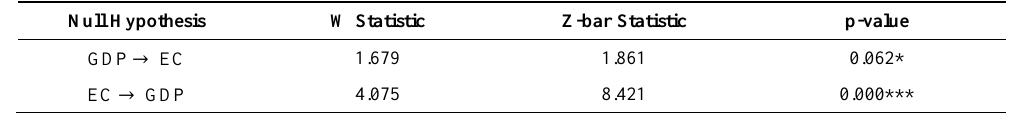
Table 7. Dumitrescu-Hurlin Panel Causality Test